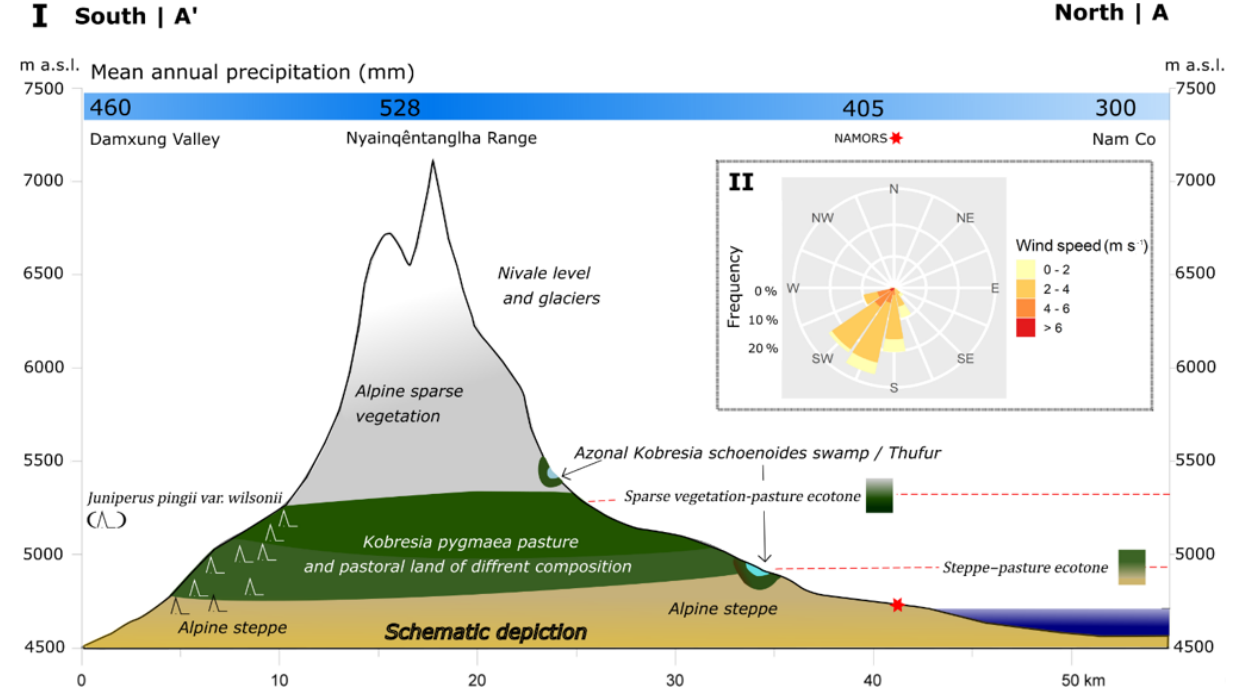
Figure 4. (I) Cross section from Damxung valley to the Nam Co study area (A’–A), as shown in Fig. 1b. Schematic depiction of altitude- dependent biomes and azonal landforms; changes in chroma denote height-dependent biome shifts. Approximate biome heights were gained from satellite imagery (Sentinel-2B) and herewith-derived vegetation indices, field excursions, and the literature review (Ohtsuka et al., 2008; Wang and Yi, 2011). (II) Frequency, direction and velocity of mean daily wind measurements at the NAMORS (30 ◦ 46 (cid:48) 22 (cid:48)(cid:48) N, 90 ◦ 57 (cid:48) 47 (cid:48)(cid:48) E) between 2005 and